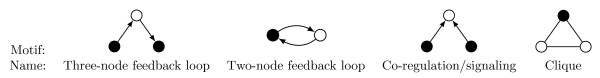
General types of motifs found in the HIV-human protein interaction network. Black nodes represent HIV proteins, white nodes represent human proteins.